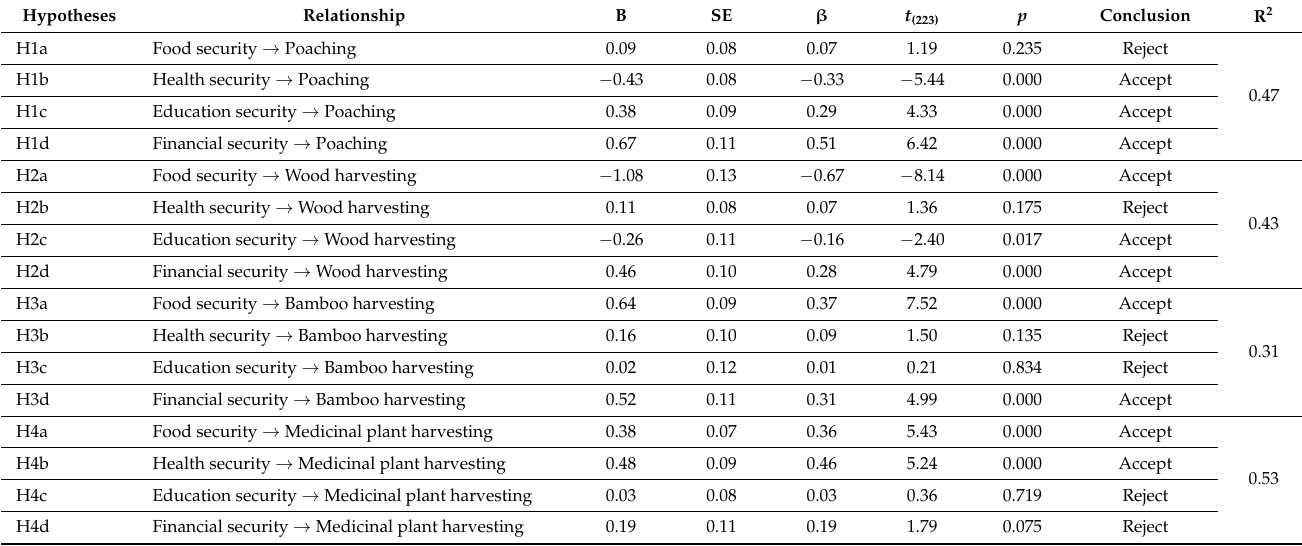
Table 5. Hypothesis Testing